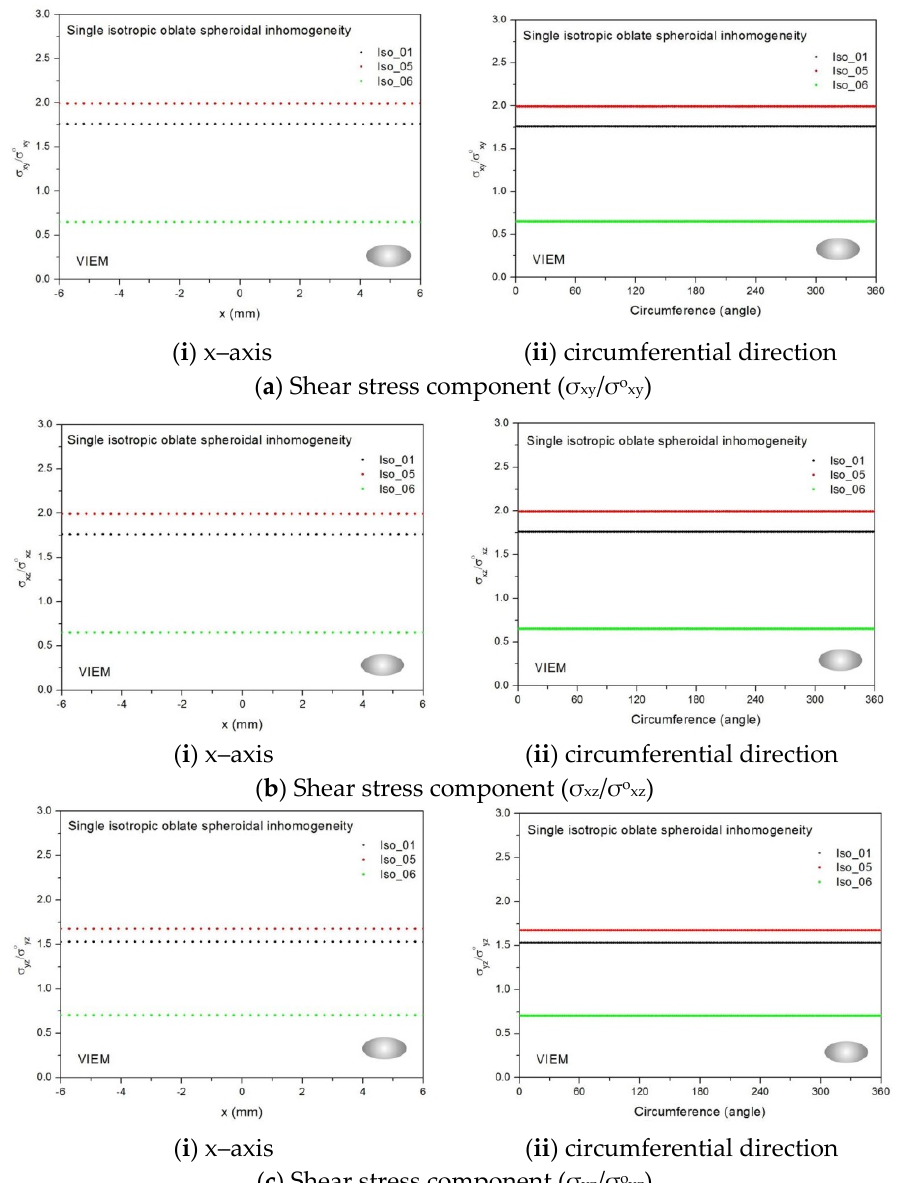
Figure 29. VIEM results for the normalized shear stress components ( a ) σ xy / σ oxy , ( b ) σ xz / σ oxz and ( c ) σ yz / σ oyz along ( i ) the x–axis inside and ( ii ) the circumferential direction of the isotropic oblate spheroidal inclusions (Iso_01, Iso_05 and Iso_06) with b/a = c/a = 0.5 (a = 6 mm) under remote shear loading ( σ oxy , σ oxz and σ oyz ).